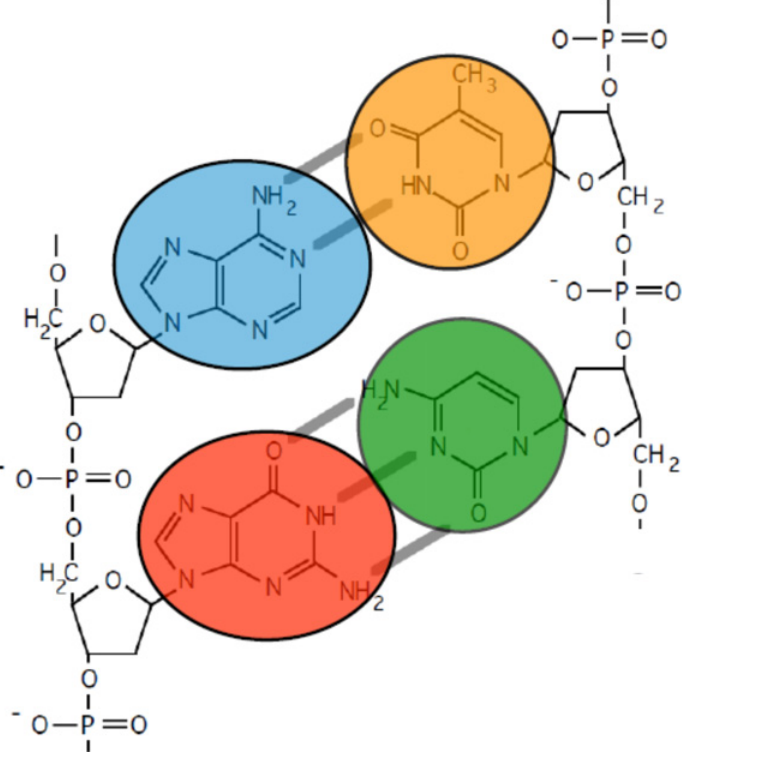
Fig 1. Composition and elemental ratios of DNA